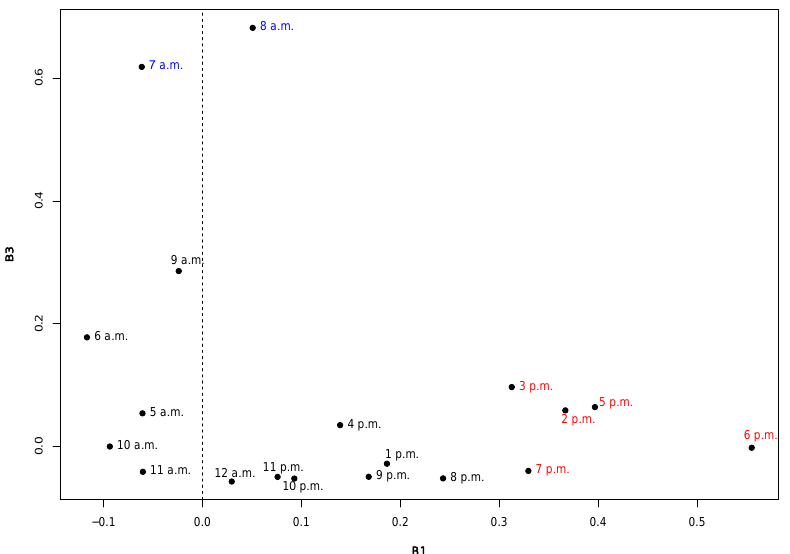
Figure 7. Loading plot (principal coordinates) for mode 2 (Timetable). Component 1 vs. Component 2 for mode 2.